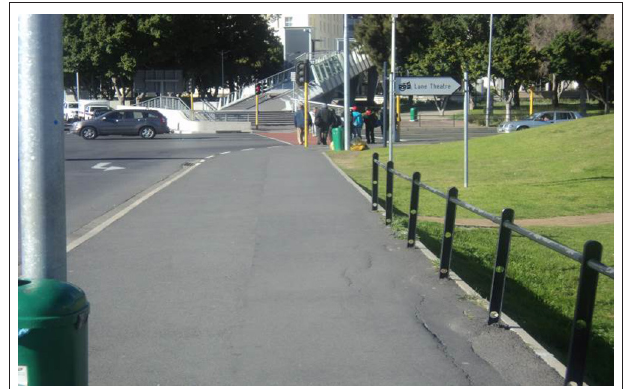
FIGURE 1 | Walking facilities in Cape Town, South Africa.